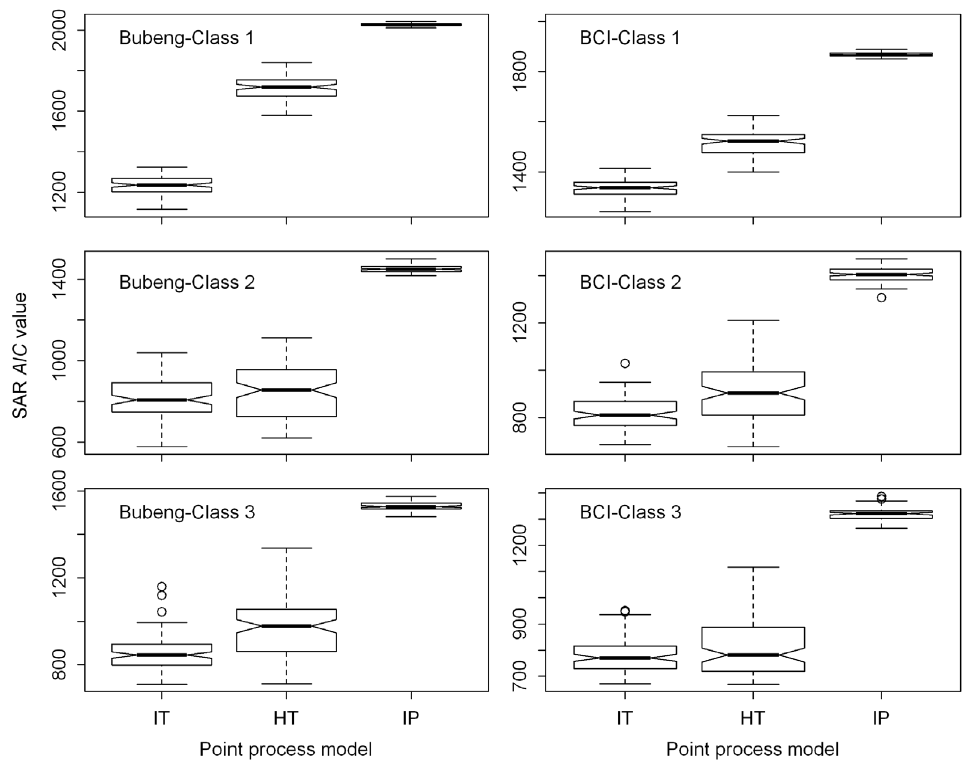
Figure 4. Boxplots of AIC value distributions of the SARs generated by the three process models for size-classes 1, 2 and 3 of the Bubeng plot and the BCI plot. HT=the homogeneous Thomas process; IP=the inhomogeneous Poisson process; IT=the